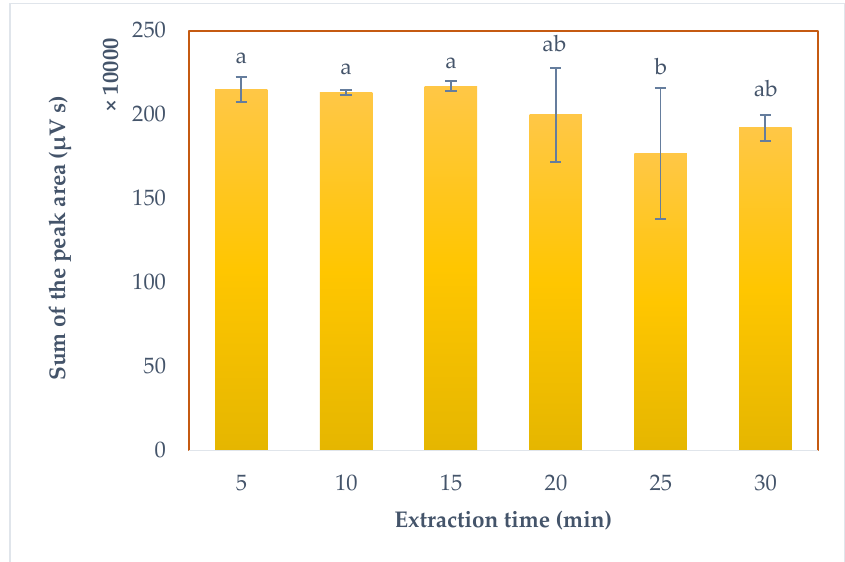
Figure 2. Average (n = 3) of the total area and standard deviations found for the phenolic compounds using the optimized extraction conditions and different extraction times. A different letter in different bars means significant differences based on Fisher LSD ( p < 0.05).